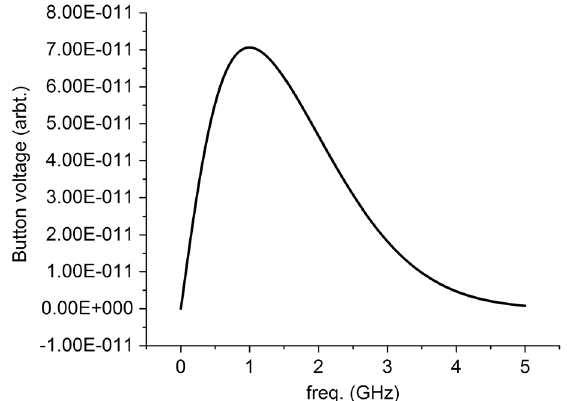
FIG. 4. Fourier transform of the voltage signal induced at the button electrode of the test BPM obtained through simulation with particle beam.